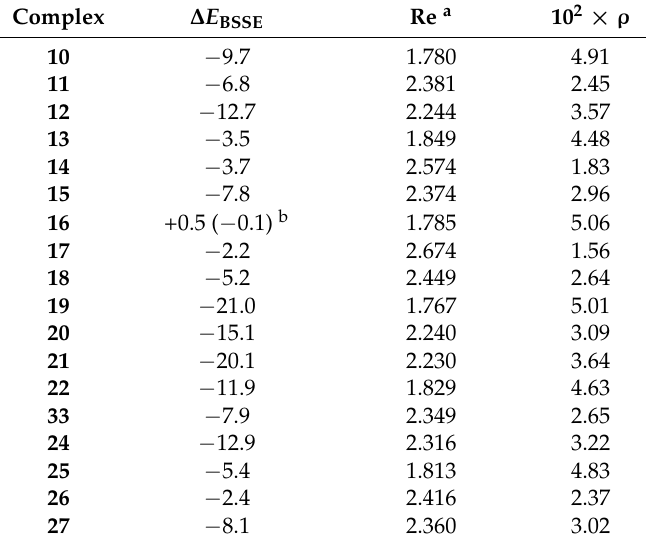
Table 1. Interaction energies with correction for basis set superposition error ( ∆ E BSSE in kcal · mol − 1 ) of complexes 10 to 27 at the RI-MP2/def2-TZVP level of theory, equilibrium distances (Re in Å) and value of the density at the bond critical point ( ρ × 10 2 in